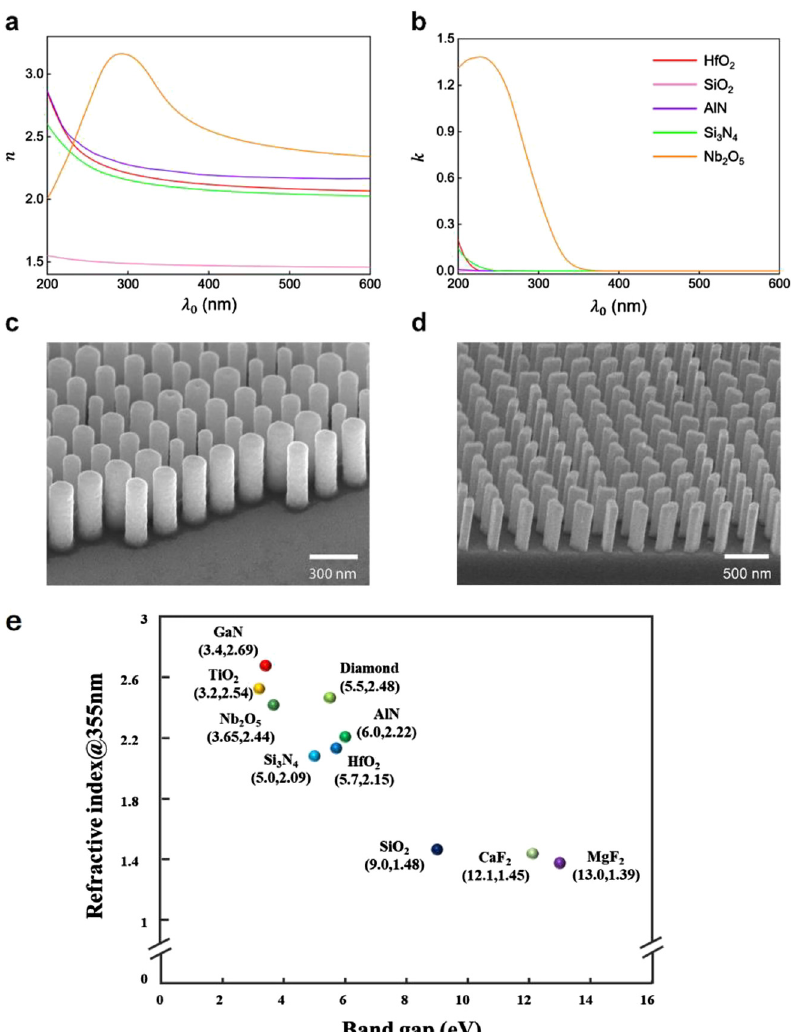
Figure 6: (a and b) Refractive index n (a) and extinction coef fi cient k (b) of representative UV-transparent dielectric materials. The legend in (b) applies to (a). (c)